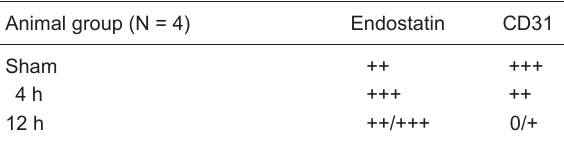
Expression of endostatin and CD31 was scored by a blinded in- dependent pathologist as: rare (0), minimal (+), moderate (++), and intense (+++). Four samples were processed for